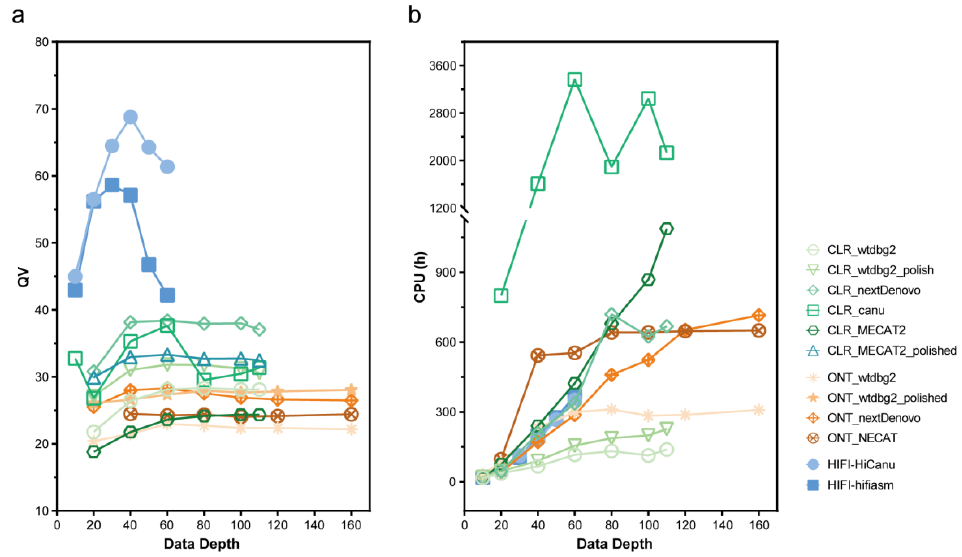
Figure 4. Quality Value (QV) score and computational time of assemblies on CLR, ONT, HIFI subsets with different data depths. ( a ) QV and ( b ) Computational time of different assemblers.